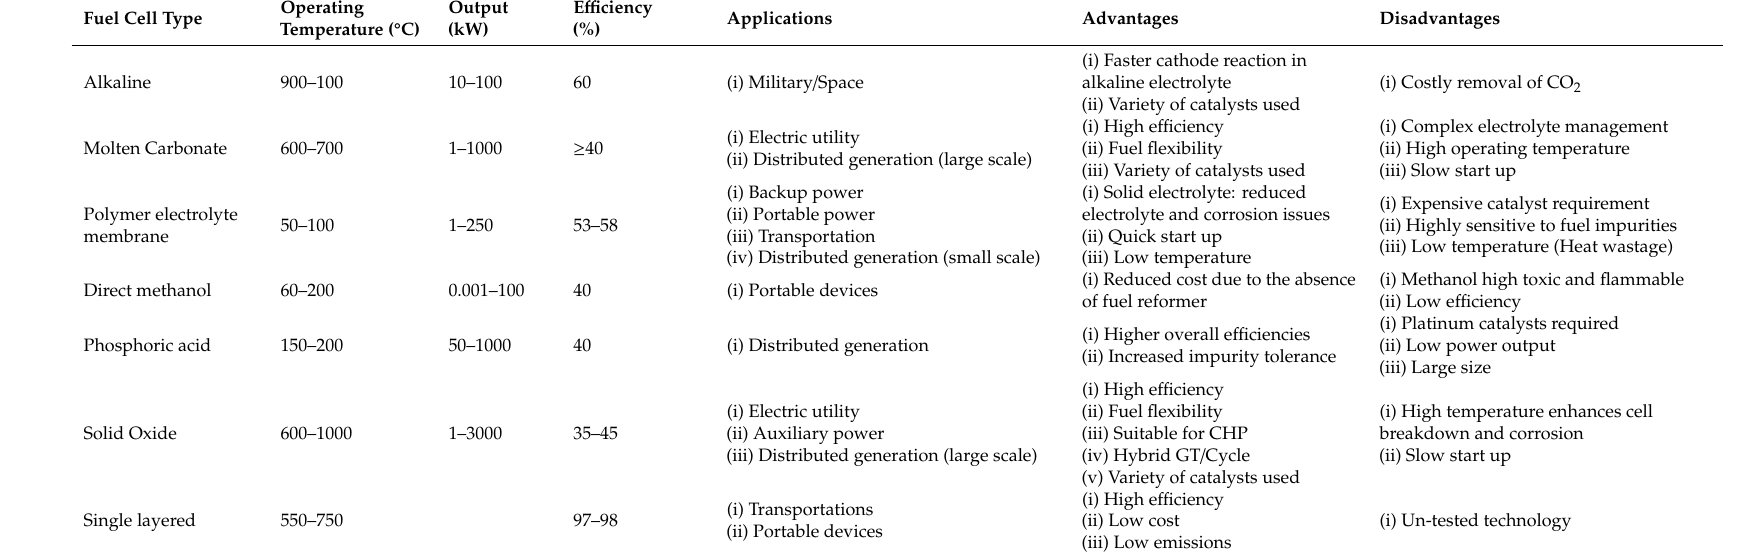
Table 8. Comparison of technical characteristics of di ff erent fuel cell technologies